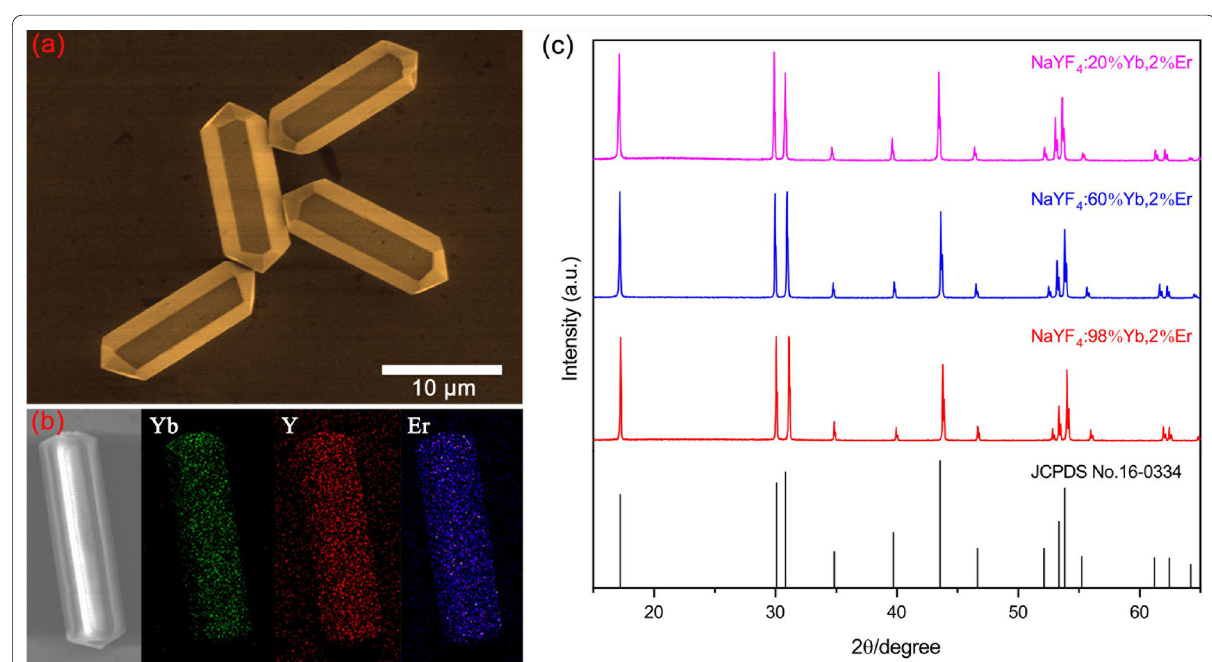
Fig. 1 a SEM images of the β-NaYF 4 :98%Yb,2%Er microcrystals. b The elements mapping of β-NaYF 4 :60%Yb,2%Er microcrystals. c XRD patterns of the β-NaYF 4 : x %Yb,2%Er